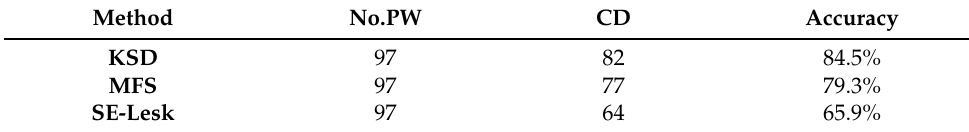
Table 2. Results of the evaluation includes method, number of polysemous word (No.PW), correctly disambiguated (CD) word, and accuracy.